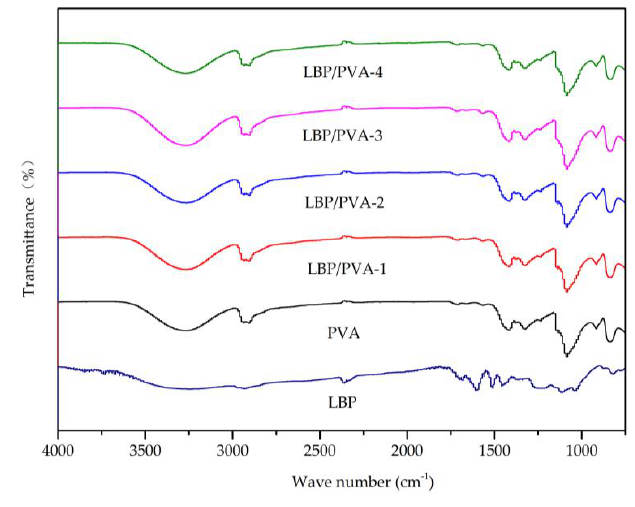
Figure 7. Fourier transform–infrared (FT-IR) spectra of LBT, PVA, and LBT/PVA membranes.